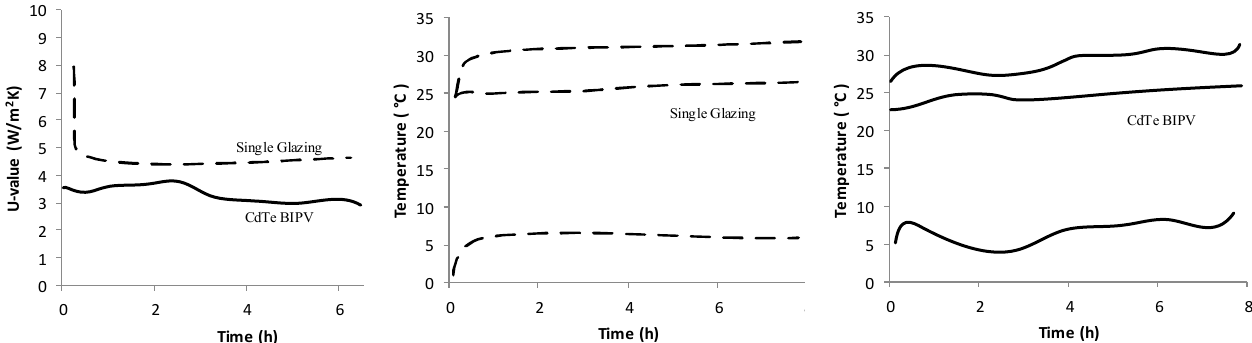
Figure 4. Overall heat transfer coefficient (U-value) of a CdTe BIPV window and a single glazed window–Indoor test [29].